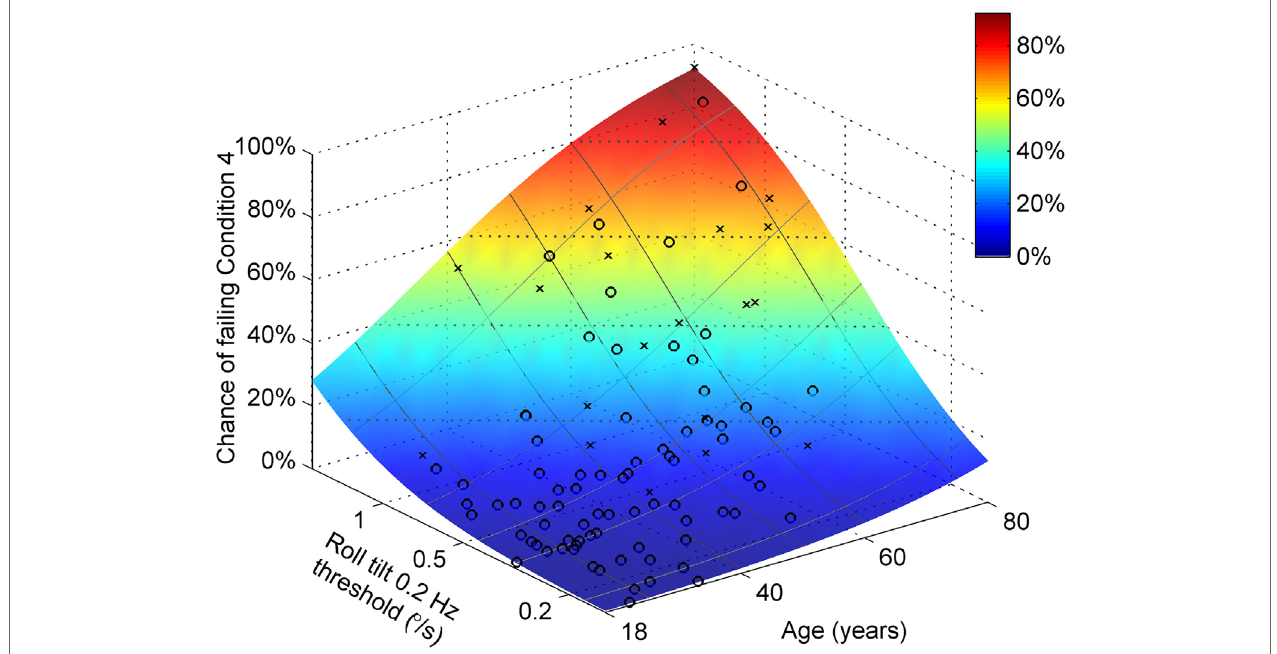
FigUre 6 | Logistic regression results showing the chance of failing condition 4 vs. both age and roll tilt 0.2 Hz thresholds determined using the model in Table 7 . Symbols show subjects who passed ( ○ ) and failed ( × ) condition